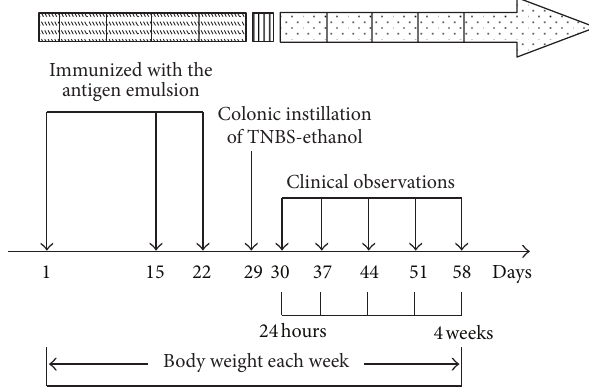
Figure 1: Schematic representation of study design. On the day 1, day 15, and day 22, the antigen emulsion was immunized in the paws and groin. On day 29, TNBS-ethanol was instilled into the colon. Clinical observation was performed after 24 hours of TNBS- ethanol enema for 4 consecutive weeks. Rats were weighed every weekend. On the end of 24-hour or 4-week administration, rats were sacrificed,